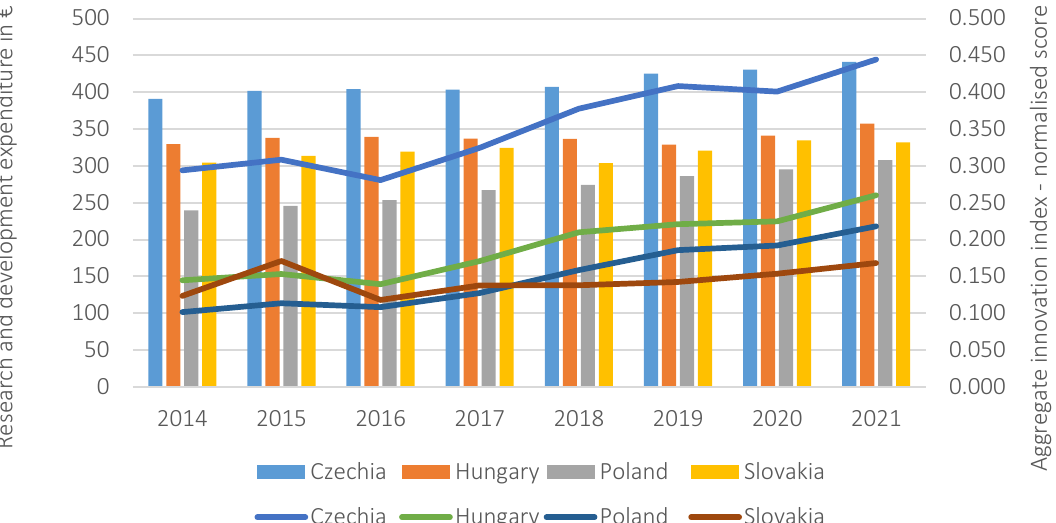
Figure 1. Development of Aggregate Innovation Index and R&D expenditure in V4